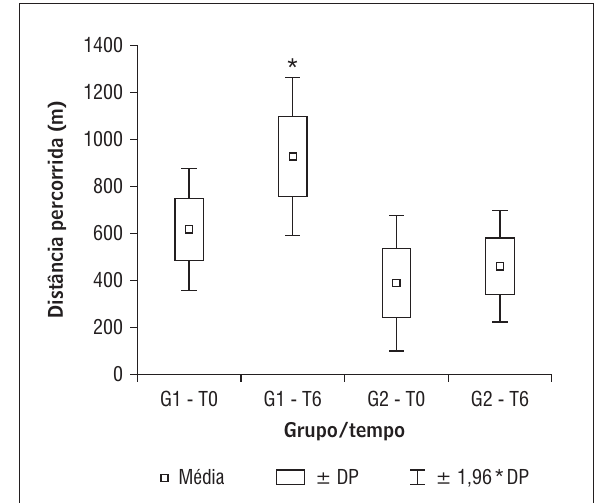
Figura 1 - Consumo máximo de oxigênio pelo organismo (VO máximo), antes (T0) e após seis semanas (T6) em mulheres entre 40 e 60 anos e da Classe I da New aeróbio (G1) e sem exercício (G2).